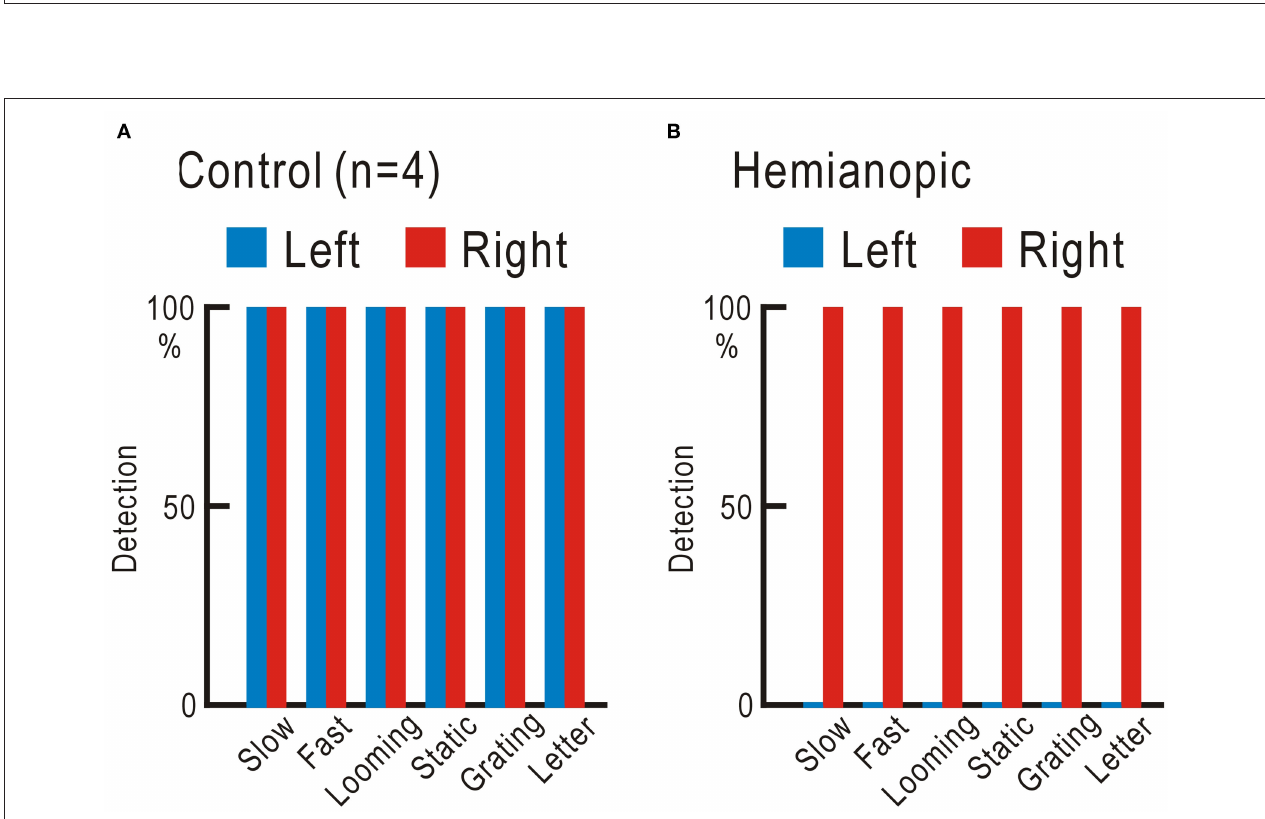
FIGURE 3 | (A) Averaged results of four control participants. In both right and left visual fields, all six types of stimuli were fully detected 10 times in 10 trials. (B) Results of the homonymous hemianopic patient. All six types of stimuli were fully detected in the right visual field, but none was detected in the left visual field.